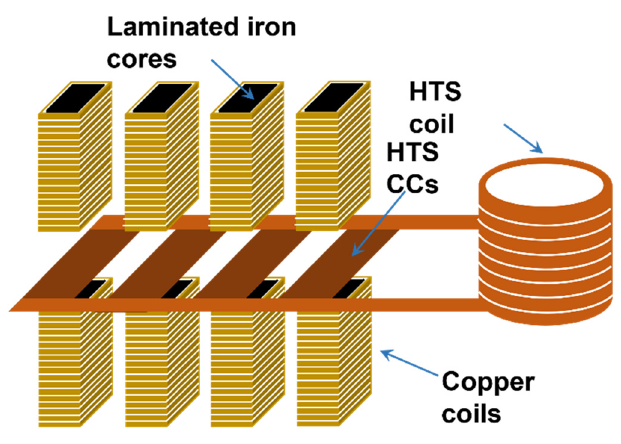
Figure 6. Schematic diagram for a linear HTS flux